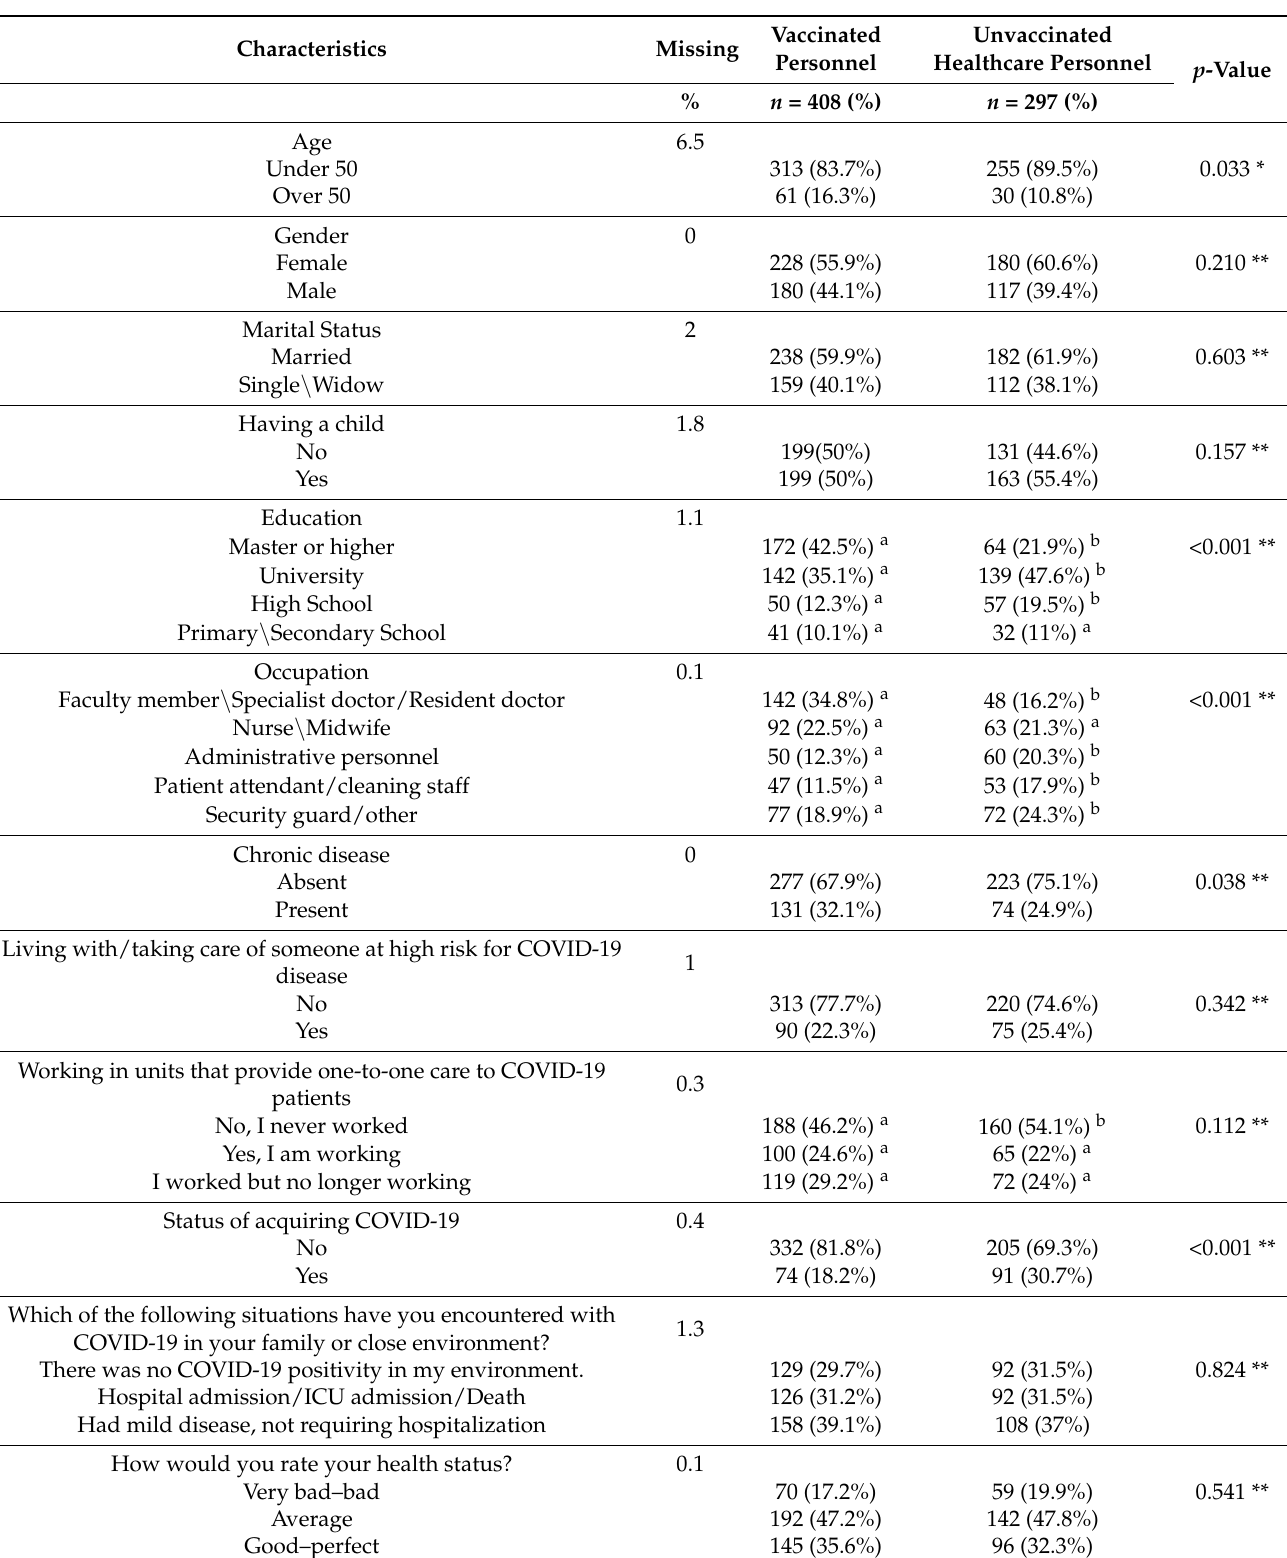
Table 2. Comparisons of vaccinated and unvaccinated healthcare personnel according to the